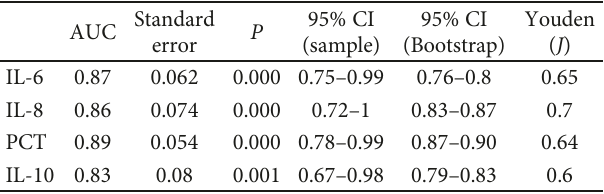
Table 6: Performance of IL-6, IL-8, PCT, and IL-10 for discrimination of sepsis on day 1 of fever. AUC: area under the ROC curve.